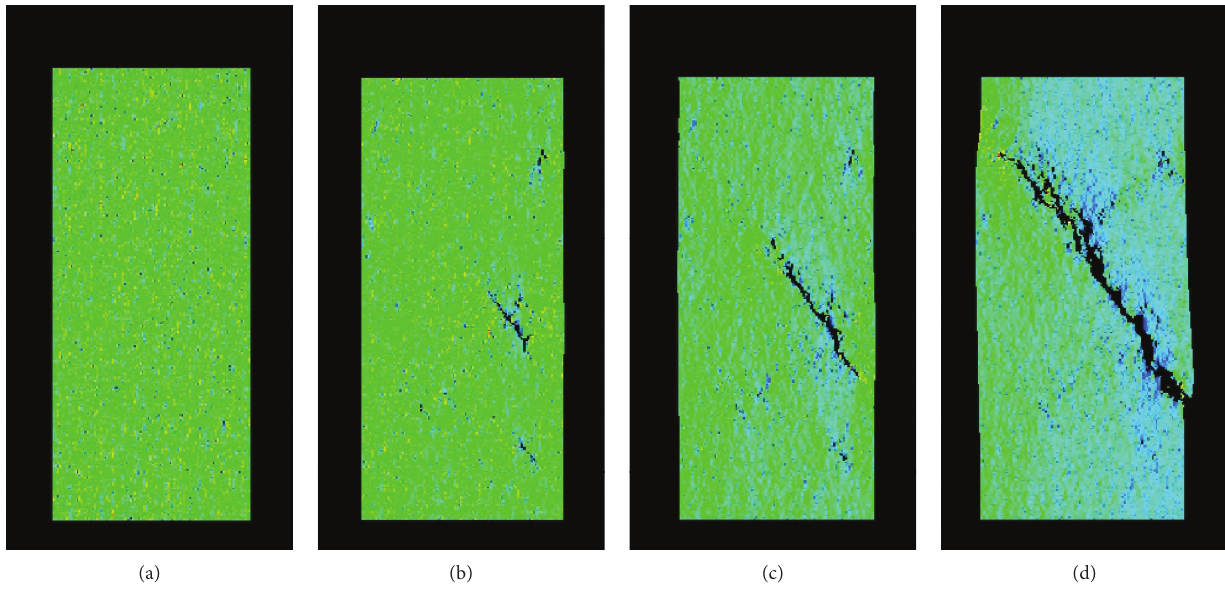
Figure 7: Macroscopic failure of rock mass at the height-to-diameter ratio of